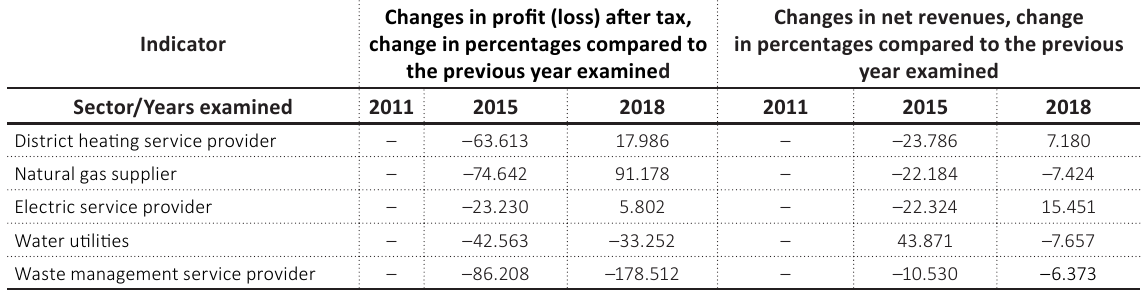
Table 4. Changes in profit (loss) after tax and net revenues of corporations examined in 2011, 2015 and 2018 (data are in